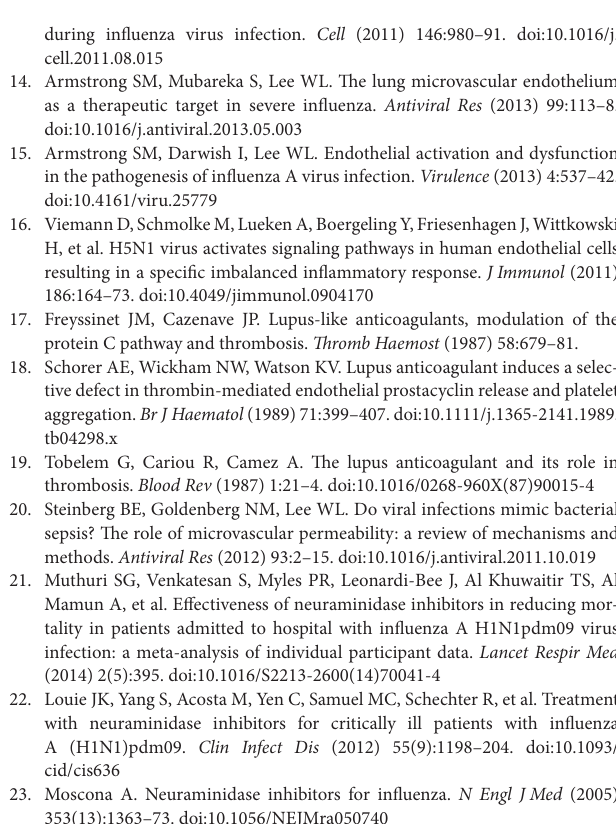
table s1 | sIRs criteria values during ICU stay